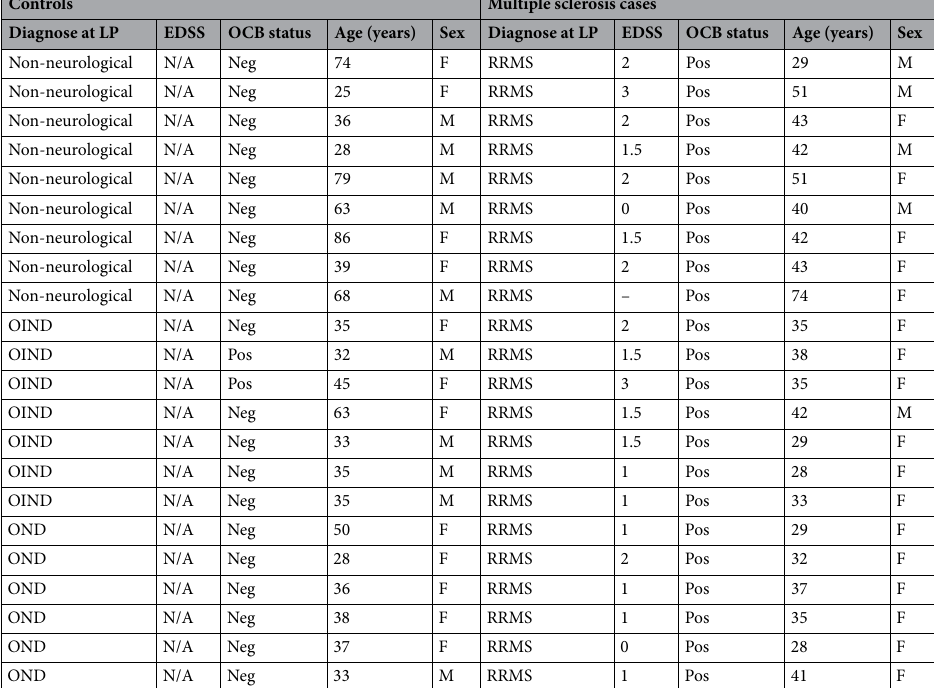
Table 2. Clinical and demographic case description of CSF sample cases at time of lumbar puncture. LP lumbar puncture, EDSS expanded disability status scale, OCB oligoclonal bands, CSF cerebrospinal fluid. – information